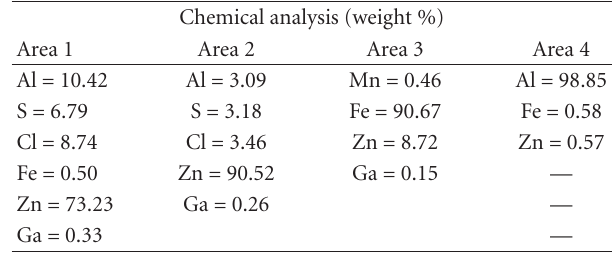
Table 5: Chemical analysis for thermal-sprayed Zn/Al, double layer, without sealer.